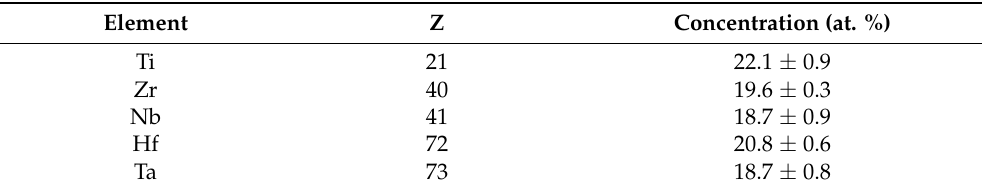
Table 3. Mean elemental composition of the deposition target obtained by EDXS. Only the content of the constituting metallic elements is included.